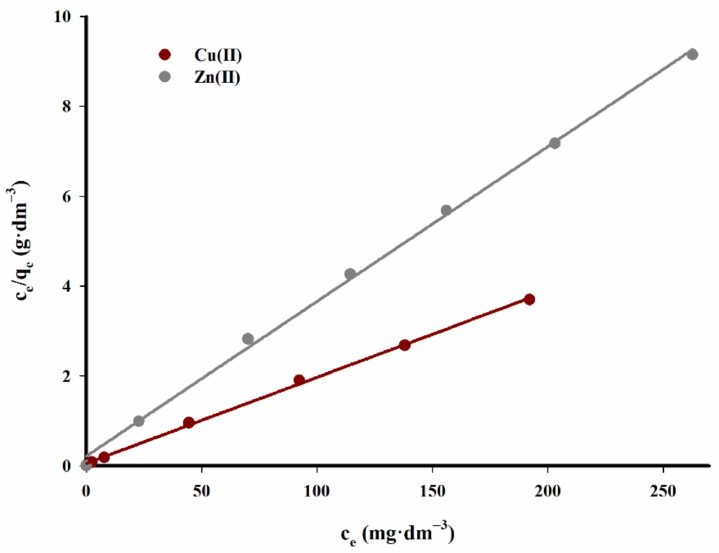
Figure 14. Langmuir isotherm fit for adsorption of copper(II) and zinc(II) ions onto studied sorbent.